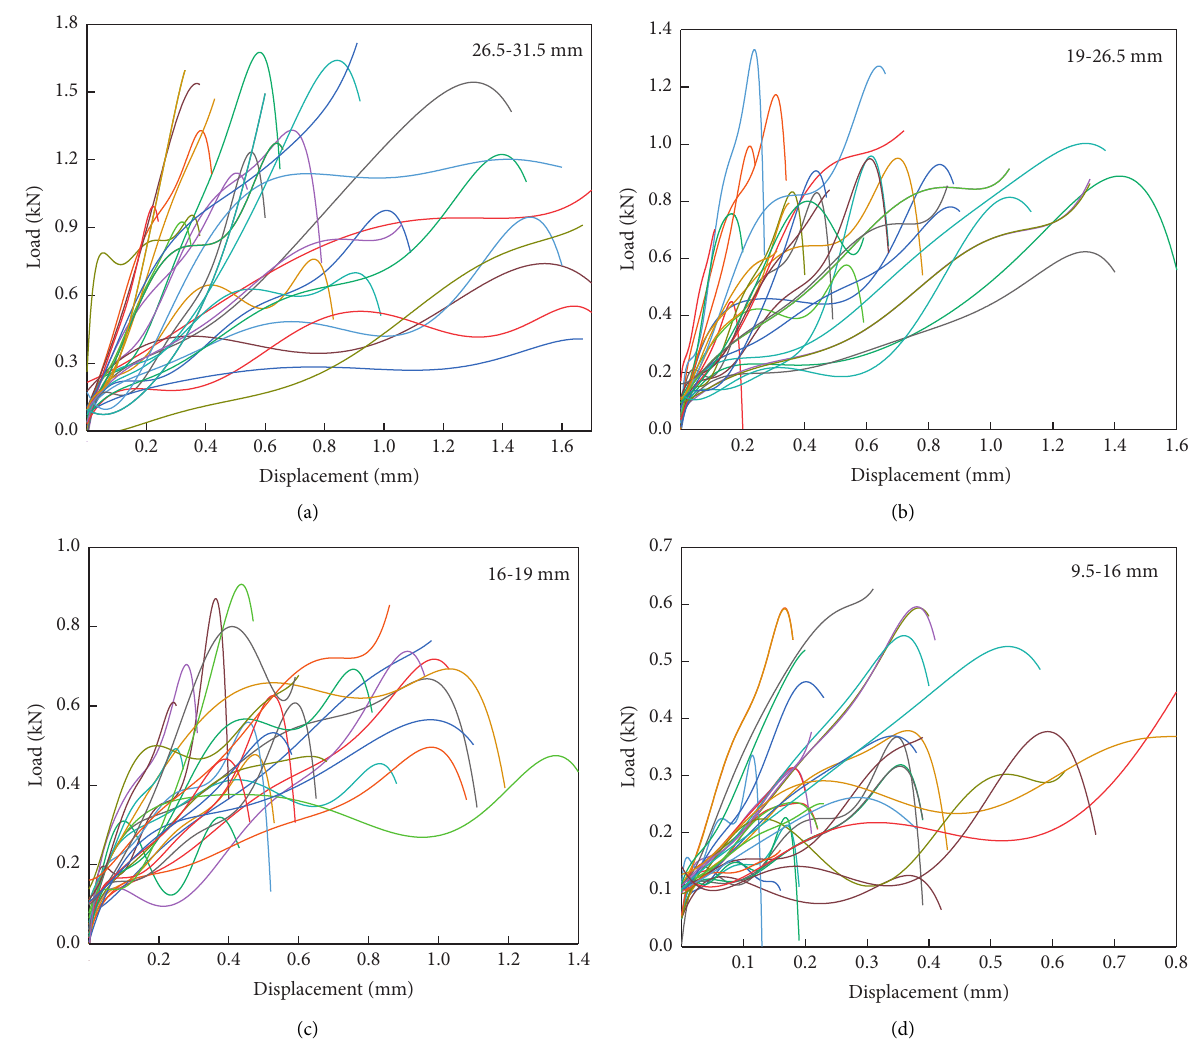
Figure 2: Load-displacement curves of recycled bricks with different particle sizes. (a) 26.5–31.5mm. (b) 19–26.5mm. (c) 16–19mm. (d) 9.5–16